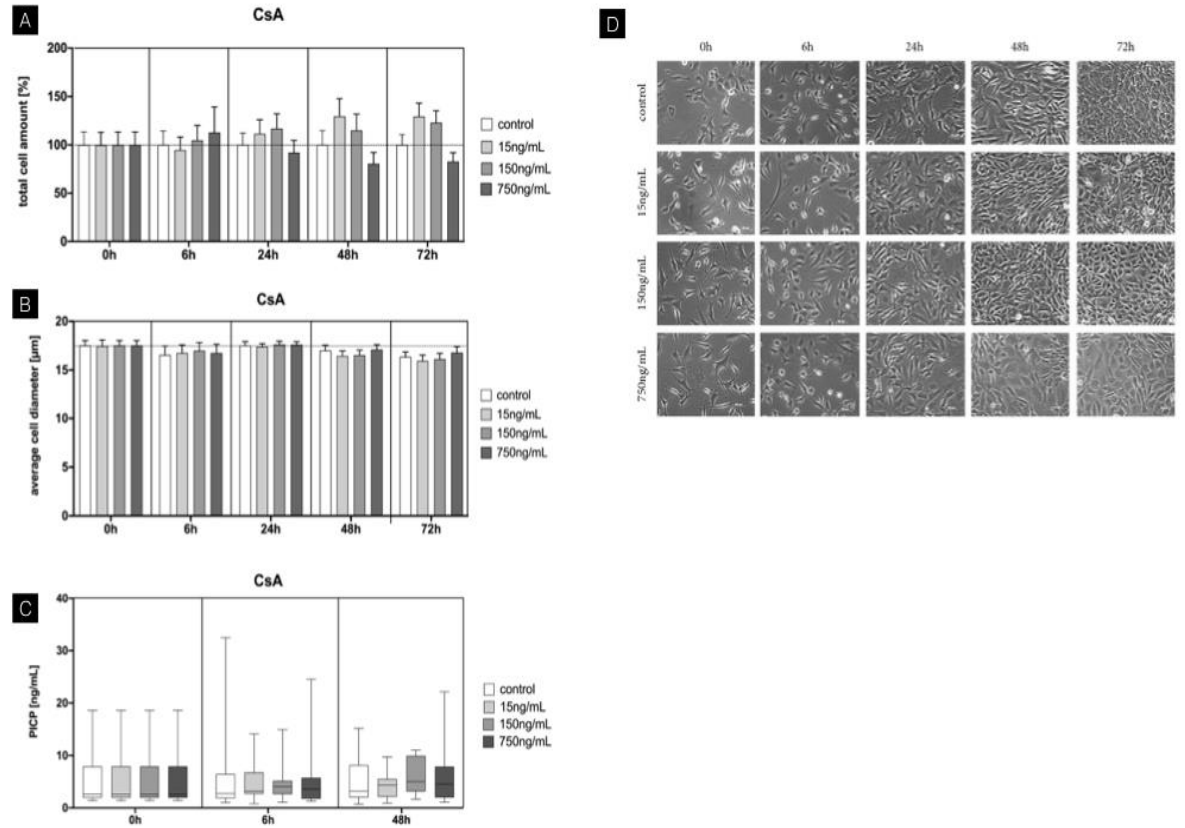
Figure 2. Time-dependent influence of cyclosporin A on mouse fibroblasts. ( A ) Total cell amount (baseline-corrected). Upregulation of cell amount after 24 h using low and intermediate concentrations of 15 ng/mL and 150 ng/Ml. ( B ) Average cell diameter showing no significant influence of CsA. ( C ) Procollagen concentration with no significant changes using different concentrations of CsA. ( D ) Cell morphology evaluation using light microscopy between 6 h and 72 h. Overall increased cell confluence with longer incubation periods. Concentration of CsA with decreased cell confluence at 48 h and 72 h using high concentrations of 750 ng/mL. Columns and error bars represent the mean ± SEM (n = 12); significant ( p < 0.05).